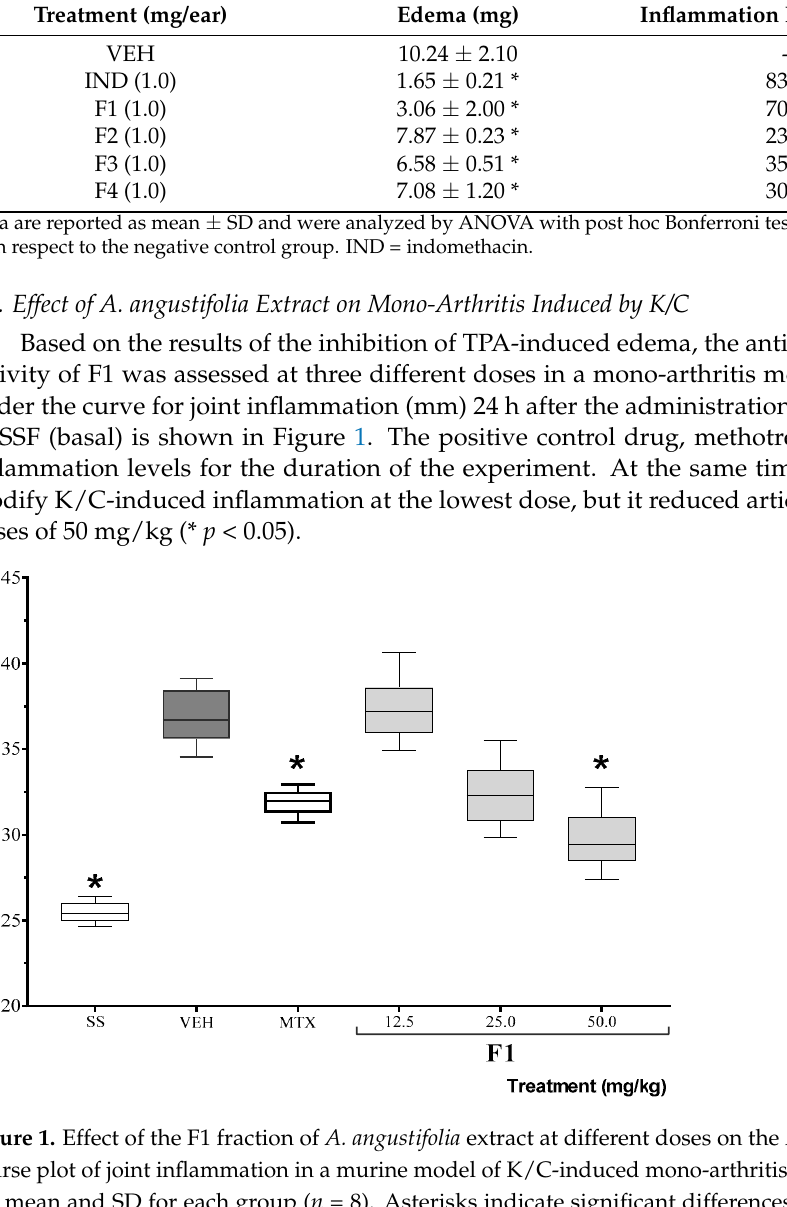
Figure 2. Effect of the F1 fraction of A. angustifolia extract at different doses on thermal hyperalgesia in inflamed joint in a murine K/C-induced mono-arthritis model. Data are reported as the mean ± SD for each group ( n = 12) and were analyzed by ANOVA with post hoc Bonferroni test. * p ≤ 0.05 with respect to the vehicle-treated group (Tween-20, VEH). SS: saline solution; MTX: methotrexate. Table 3. Effect of the F1 fraction of A. angustifolia extract on spleen index (percentage of total body weight). Treatment (mg/kg)